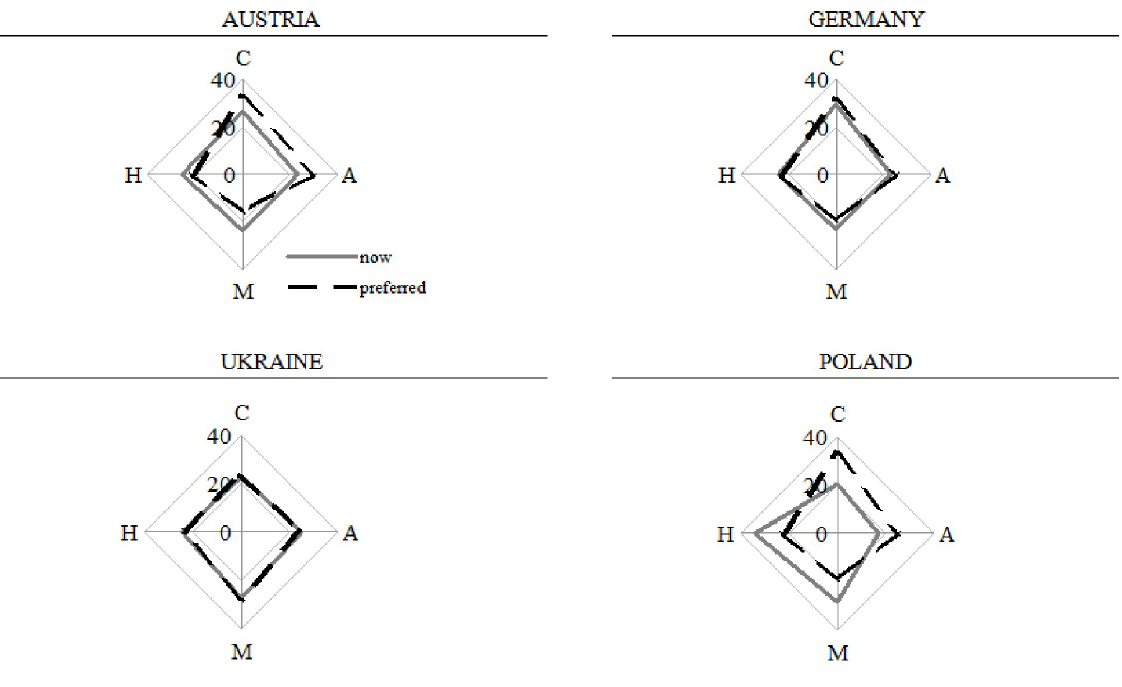
Fig 5. Mean organisational culture profiles in the selected countries. Areas: general characteristics of the organisation (I), leadership style (II), personnel management style (III), organisation integrity (IV), key areas in the organisation (V), success criteria (VI). Profile: Clan (C), Adhocracy (A), Market (M), Hierarchy